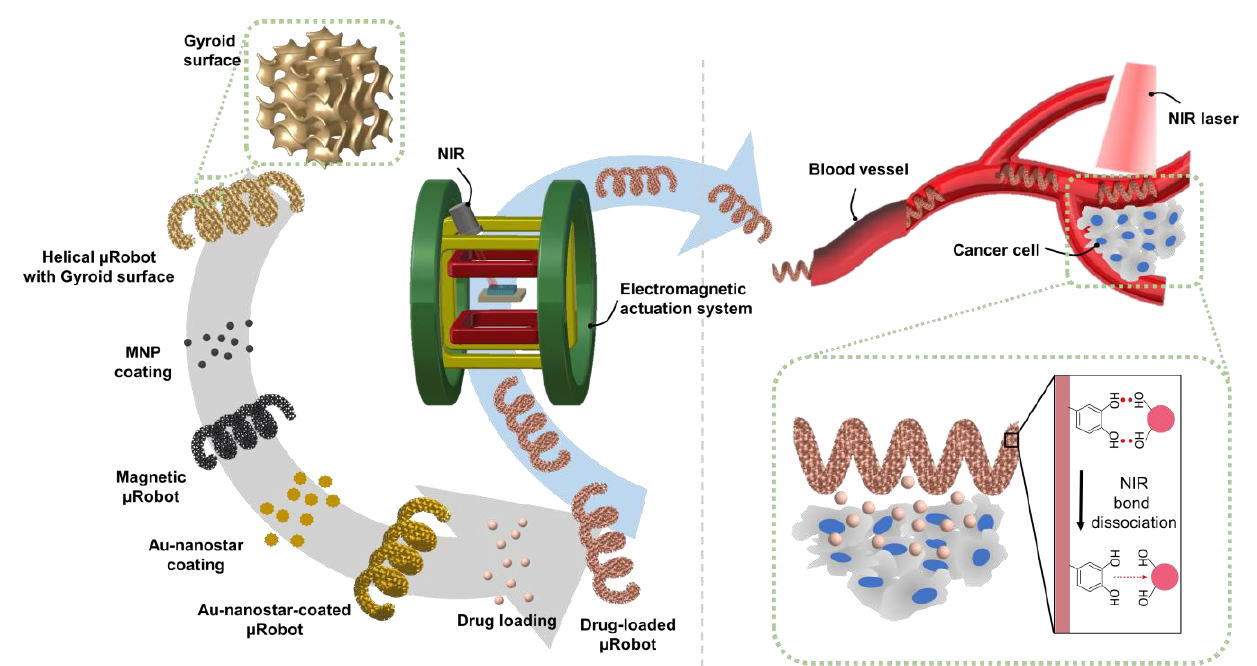
Figure 1. Schematic illustration of the proposed Gyroid surface-helical microrobot (GS-HM). The GS-HM is fabricated using the two-photon polymerization (TPP) method. Then, magnetic nanopar-ticles (MNP) (for magnetic actuation), Au-nanostar (for photothermal therapy), and the drug (for chemotherapy) are coated on the surface of the GS-HM. The GS-HM can be magnetically controlled in a blood vessel using a EMA system, and photothermal therapy can be realized through near-infrared (NIR) irradiation.